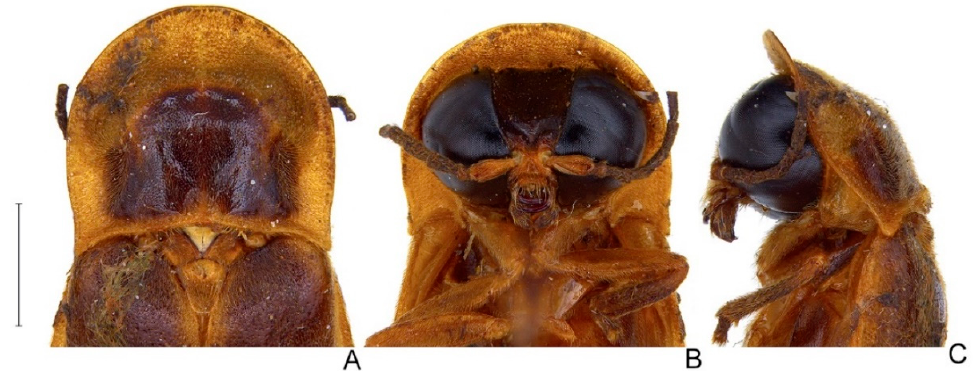
Figure 8. Zoiudo araucariorum sp. nov., ( A ) pronotum, dorsal. ( B ) Head, frontal. ( C ) Head and prothorax, lateral. Scale bar: 2 mm.